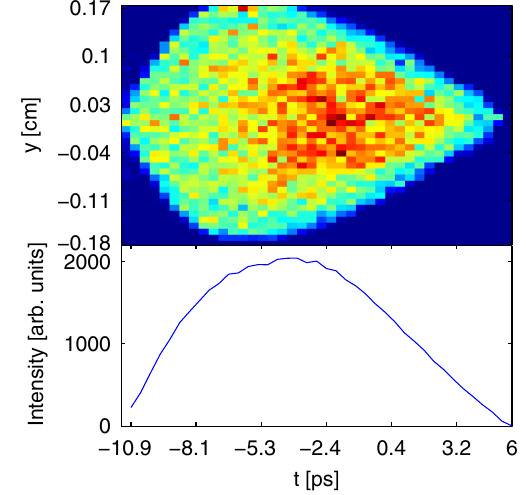
FIG. 2. PARMELA simulation of the beam as seen at the dipole entrance, after secondary acceleration in a booster cavity. As can be seen the beam assumes an ellipsoidal shape, with some distortion at beam rear due to image charge. Below the configu- ration space plot is the projected temporal distribution from PARMELA at the dipole entrance, showing the approximately half-circle beam profile.